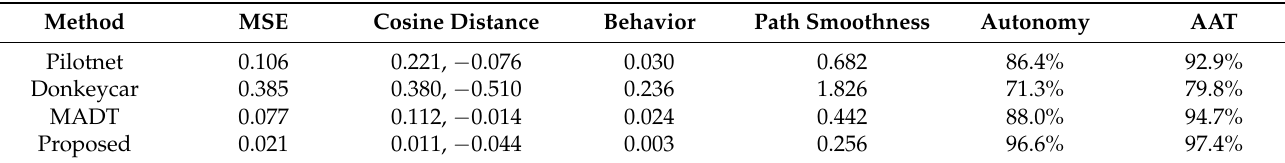
Table 1. Quantitative results of simulation